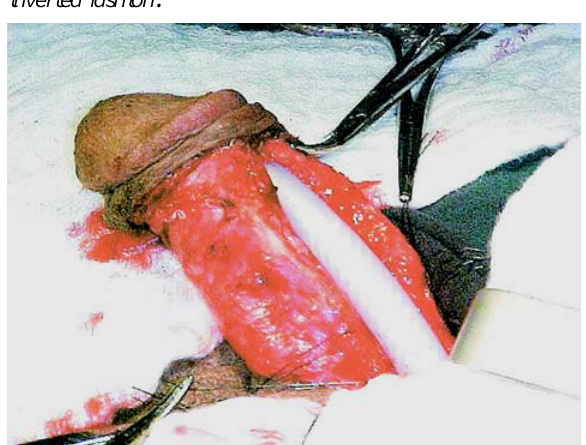
Figure 2 – AMS 650 prosthesis with the inferior extremity inserted in the gland.